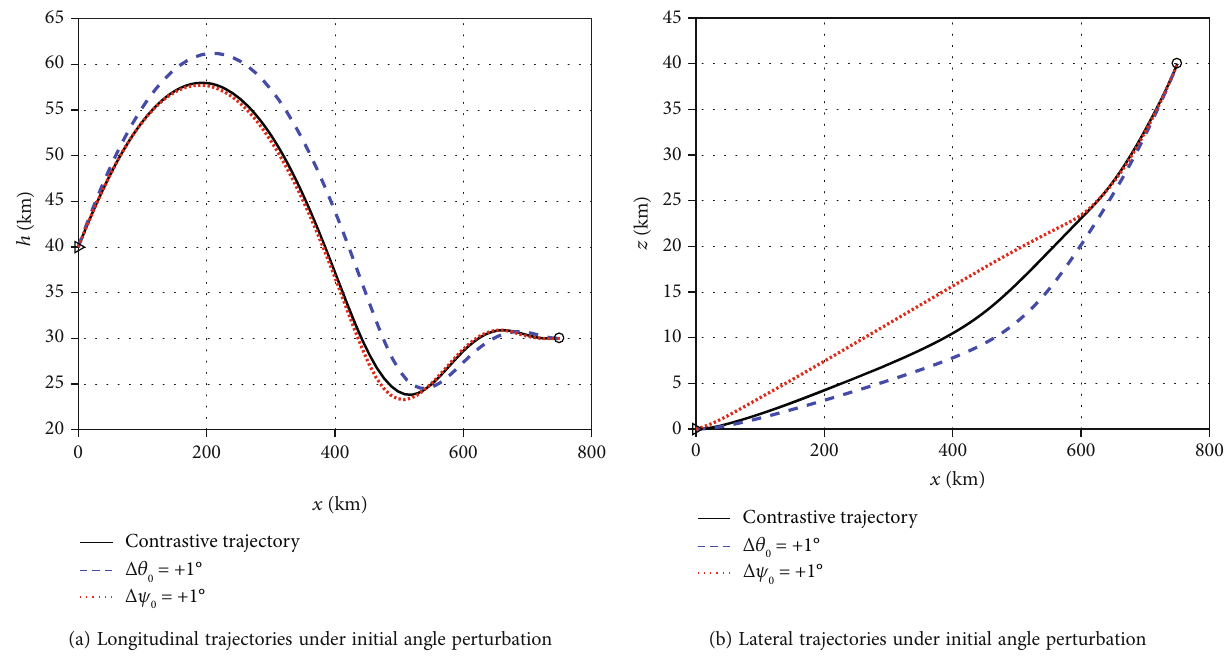
Figure 7: Trajectories under initial angle